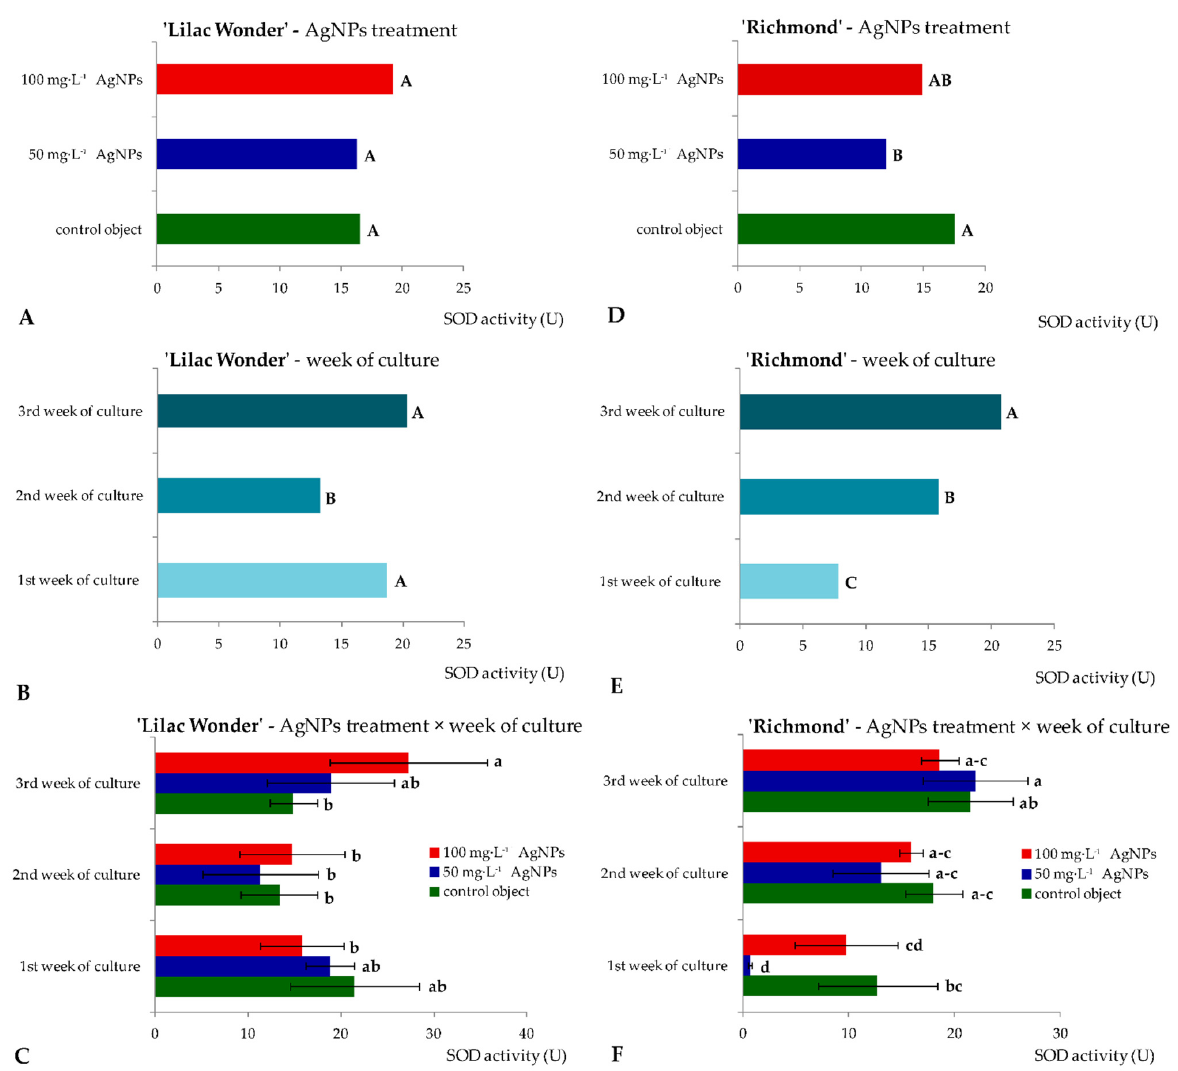
Figure 4. Activity of superoxide dismutase in Chrysanthemum × grandiflorum ‘Lilac Wonder’ (graphs A – C ) and ‘Richmond’ (graphs D – F ) leaf explants cultured in vitro on the modified MS medium